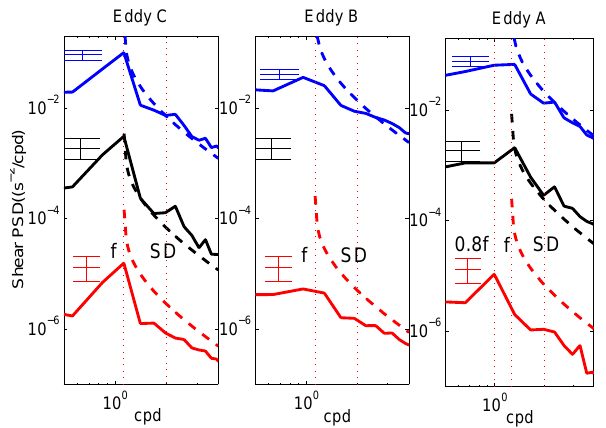
Figure 4: Frequency spectra of LADCP vertical shear for the three eddies averaged over different depth intervals: in blue [30–500]m, in red [30–100]m, in black [400–500]m for eddy C; and [200–300]m for eddy A. A two decades shift was applied between each curve. The reference spectrum, the GM model, is displayed in dashed lines for comparison. Vertical dashed lines mark the near inertial fre- quency ( f ) and semi-diurnal (SD) tide frequency. Vertical bars in- dicate confidence